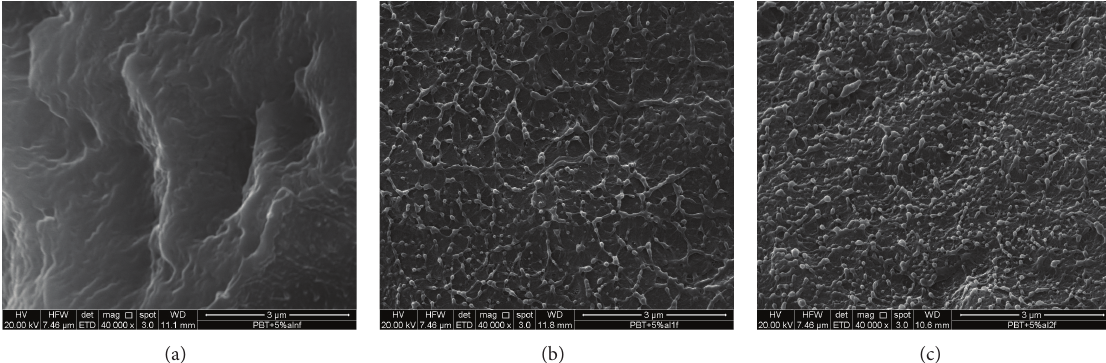
Figure 2: SEM micrographs of fracture surfaces of samples containing 5% by weight of alumina whiskers as received (a), functionalized with GPS (b), and functionalized with MPS (c).